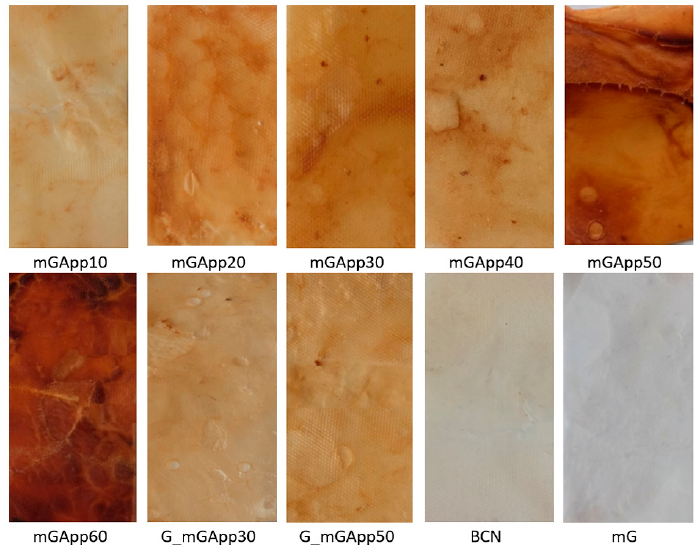
Figure 1. Morphology of the native bacterial cellulose (BCN); bacterial cellulose pre-treated by bleaching and swelling followed by modification with glycerol (mG); BC pre-treated and then modified by glycerol followed by the entrapment of apple powder at concentrations ranging from 10 to 60% (mGApp10, mGApp20, mGApp30, mGApp40, mGApp50, and mGApp60); and BC pro- duced in media with AP, pre-treated, and subsequently modified with glycerol and AP at a concen- tration of 30% (G_mGApp30) or 50%